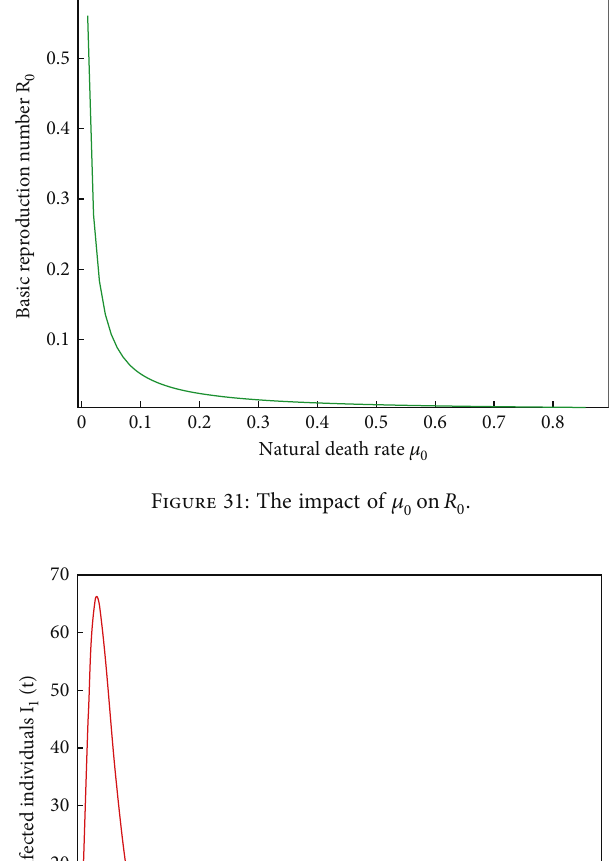
Figure 29: Variation of di ff erent individuals when R